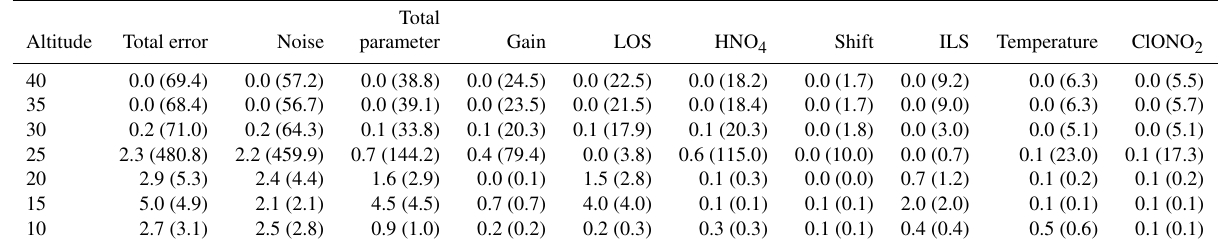
Table 2. Error estimates for a midlatitude profile during the FR period. Errors are given in pptv (relative errors in %).